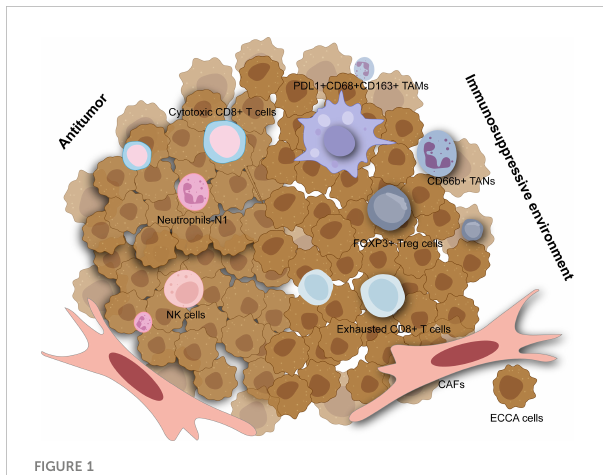
FIGURE 1 The tumor microenvironment in extrahepatic cholangiocarcinoma. The immunosuppressive environment is mainly composed of tumor-associated macrophage (TAMs), tumor-associated neutrophils (TANs), regulatory T cells (Tregs), exhausted CD8+ T cells and cancer-associated fi broblasts (CAFs) which are all associated with worse outcomes. Cytotoxic CD8+ T cells, neutrophils with N1 phenotype, and natural killer (NK) cells can